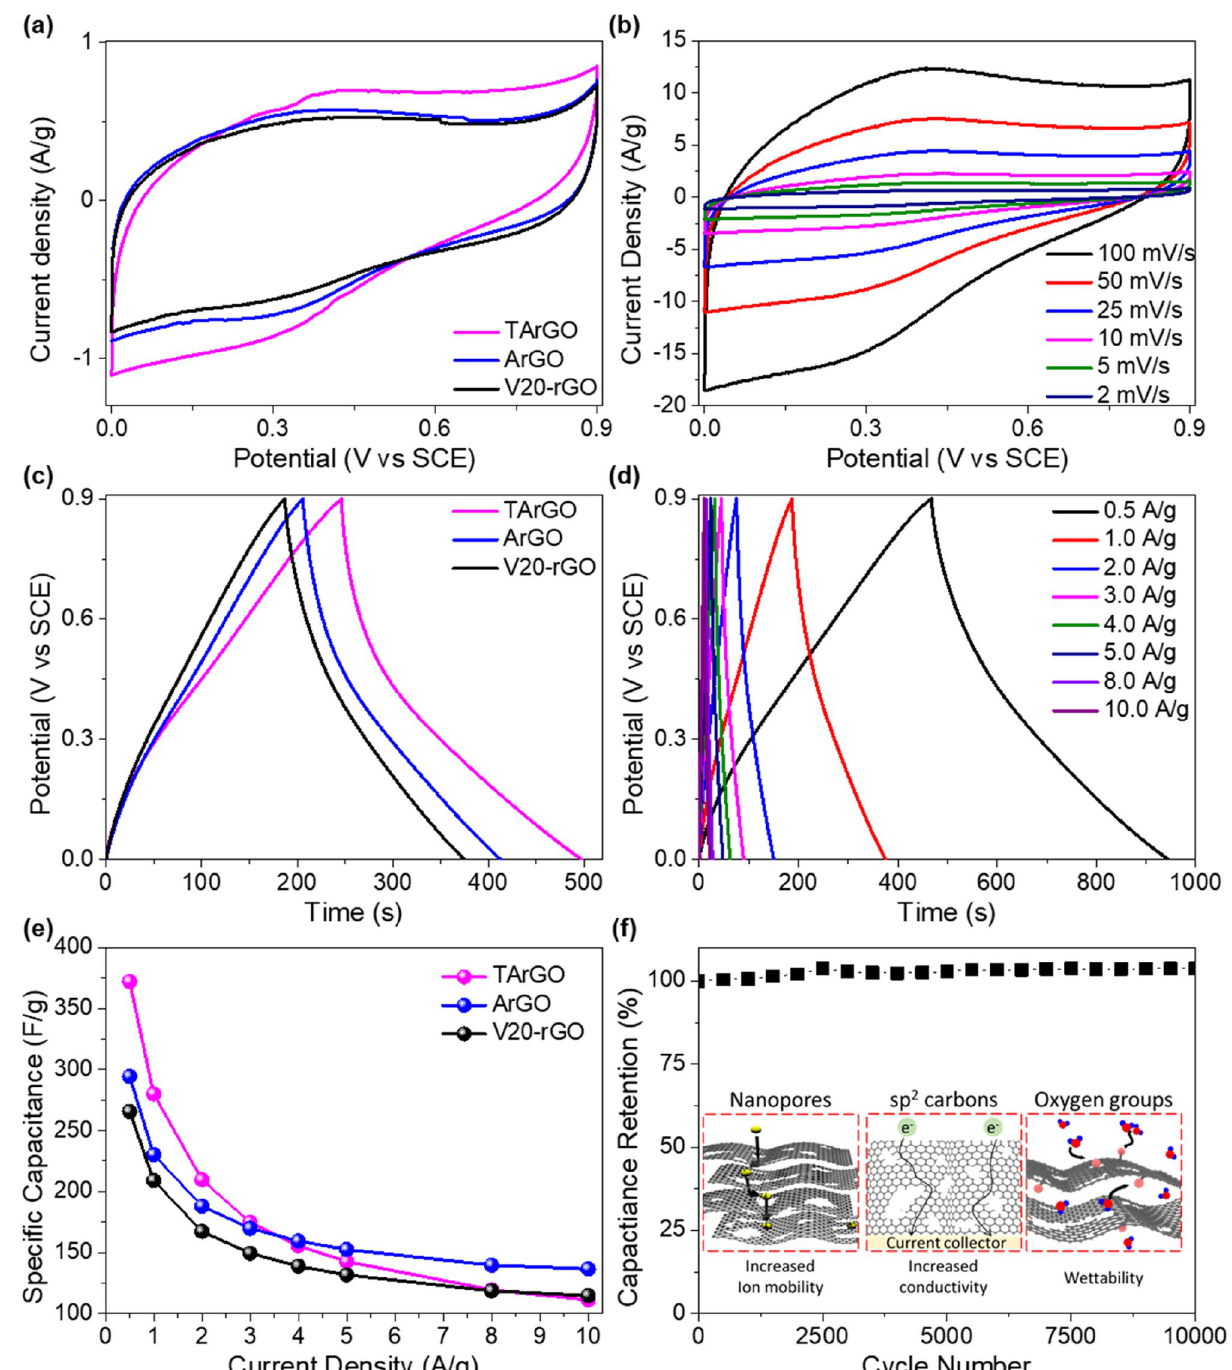
Figure 3. ( a ) Cyclic voltammetry curves of V20-rGO, activated reduced graphene oxide (ArGO), and thermally treated ArGO (TArGO) at a scanning rate of 2 mV/s. ( b ) Cyclic voltammetry curves of TArGO depending on the potential sweep rates. ( c ) Galvanostatic charge/discharge curves of V20-rGO, ArGO, and TArGO under a constant current density of 1 A/g. ( d ) Galvanostatic charge/discharge curve of TArGO depending on the constant current densities. ( e ) Specific capacitances of V20-rGO, ArGO, and TArGO as functions of constant current density. ( f ) Specific capacity vs cycle number of TArGO at a constant current density of 10